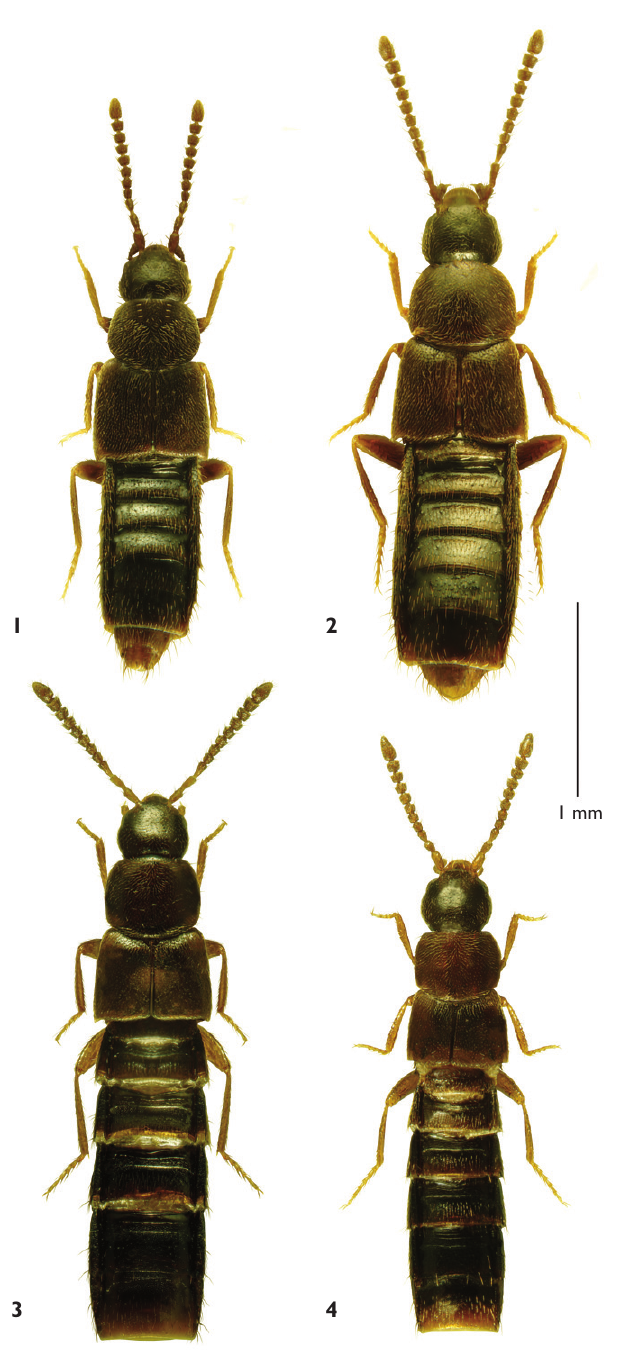
Figures 1–4. Schistoglossa species, dorsal images: 1 S. charlottae 2 S. campbelli 3 S. pseudocampbelli 4 S. brunswickensis